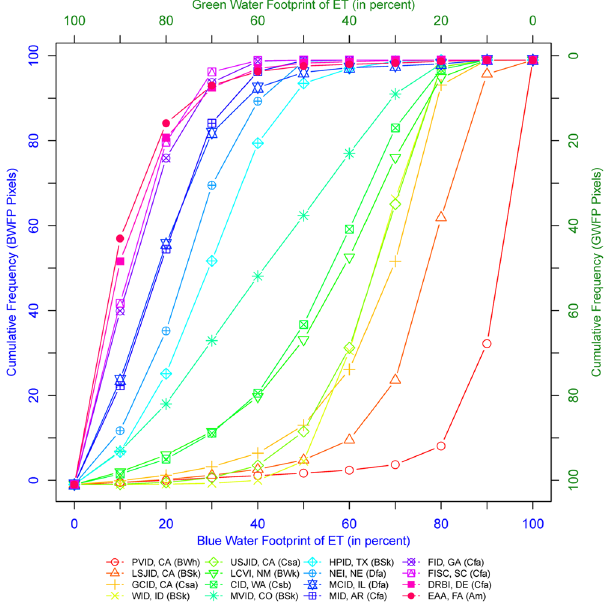
Figure 6. Cumulative distribution of the number of pixels with percent BWET and GWET summarized for 16 different irrigated areas and their hydro-climatic zones. The figure was generated using R 3.3.0 software https://